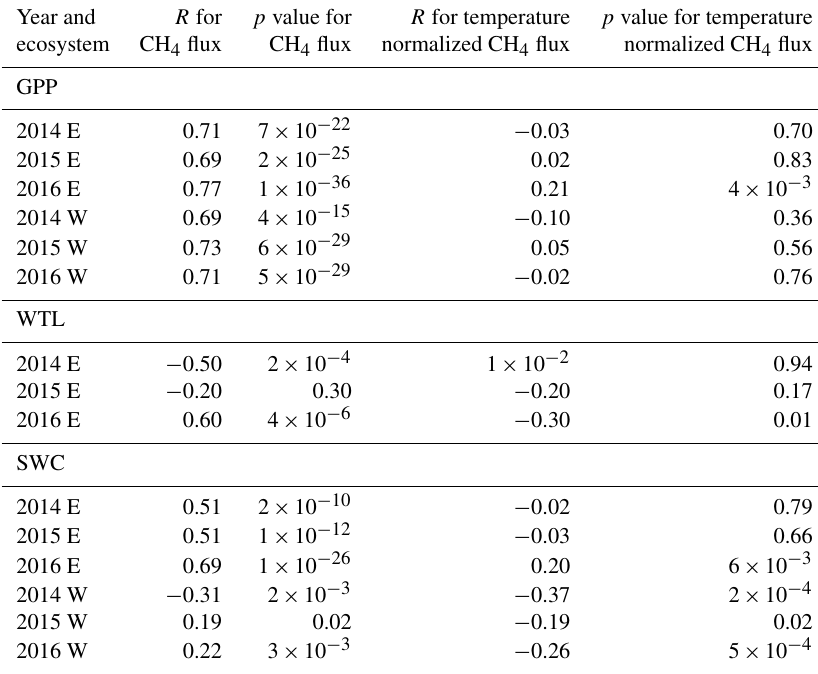
Table 6. Summary of controlling factors before and after temperature normalization.